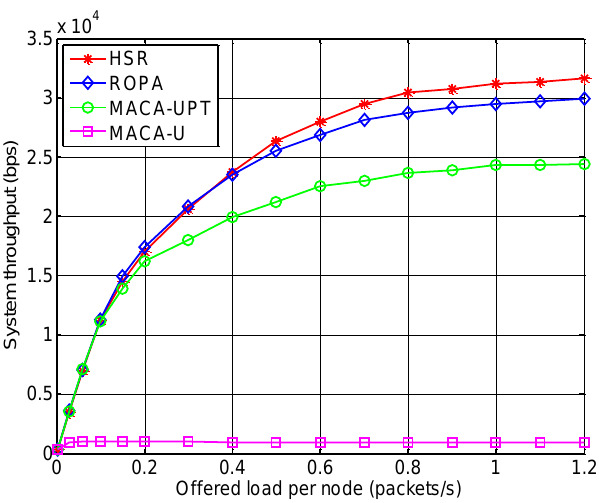
Figure 13. System throughput for HSR compared with other MAC protocols.